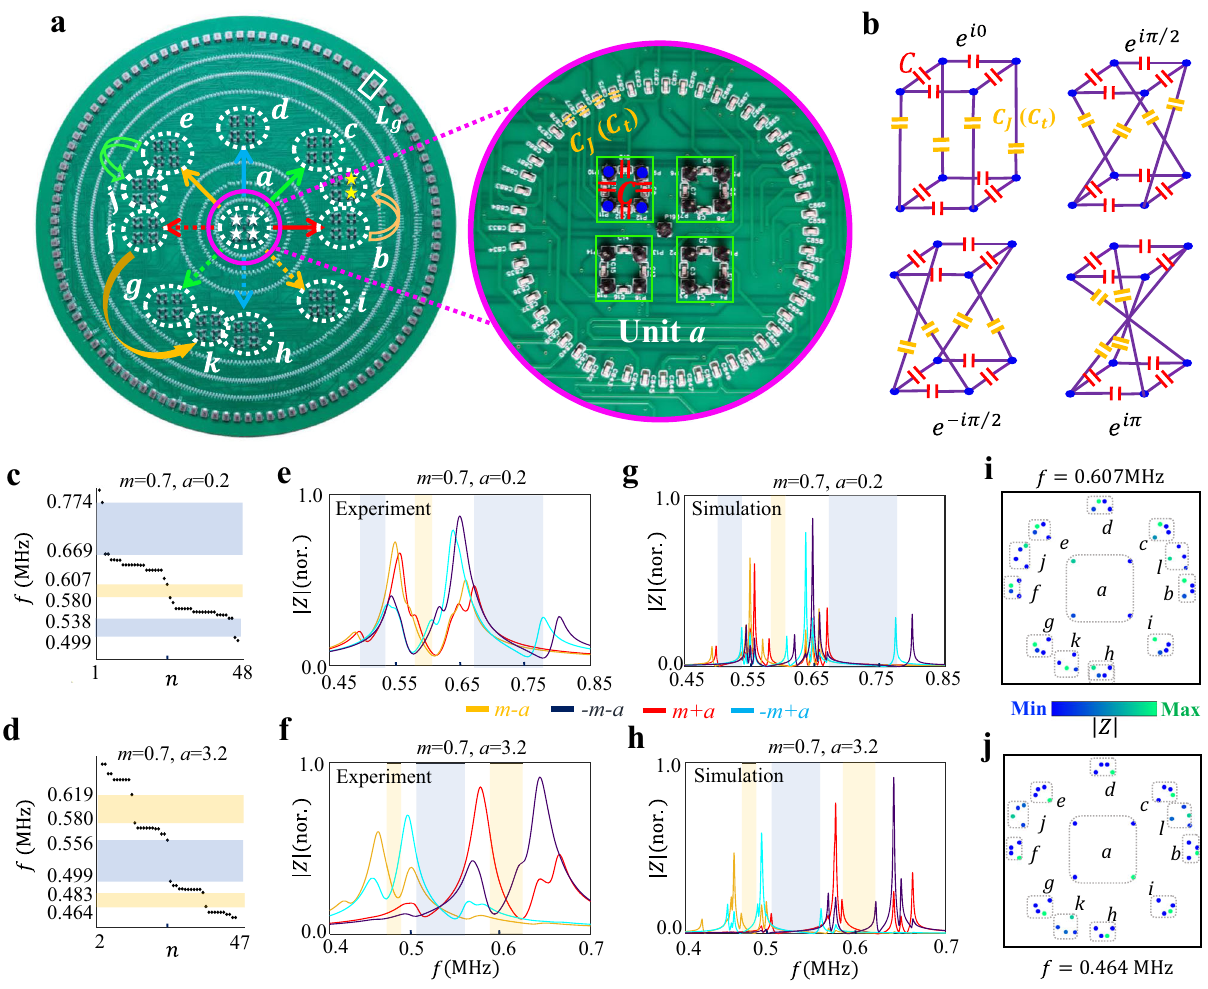
Fig. 3 | Experimental results on hyperbolic band topology with second Chern numbersinarti fi cialcircuitnetworkswithPBCs.a Thephotographimageofthe fabricatedhyperboliccircuitsampleunderPBCs.Rightchartspresentthefrontand back sides of enlarged views. White dash circles labeled from ‘ a ’ to ‘ l ’ label twelve units of the fi nite hyperbolic lattice model. Group generators γ 1 to γ (cid:1) 1 4 are marked by eight colored arrows. b The schematic diagram for the realization of different inter-cell couplings. c , d The recovered circuit frequency spectra with the mass term being ( m =0.7, a =0.2) and ( m =0.7, a =3.2) under PBCs. e , f The measured